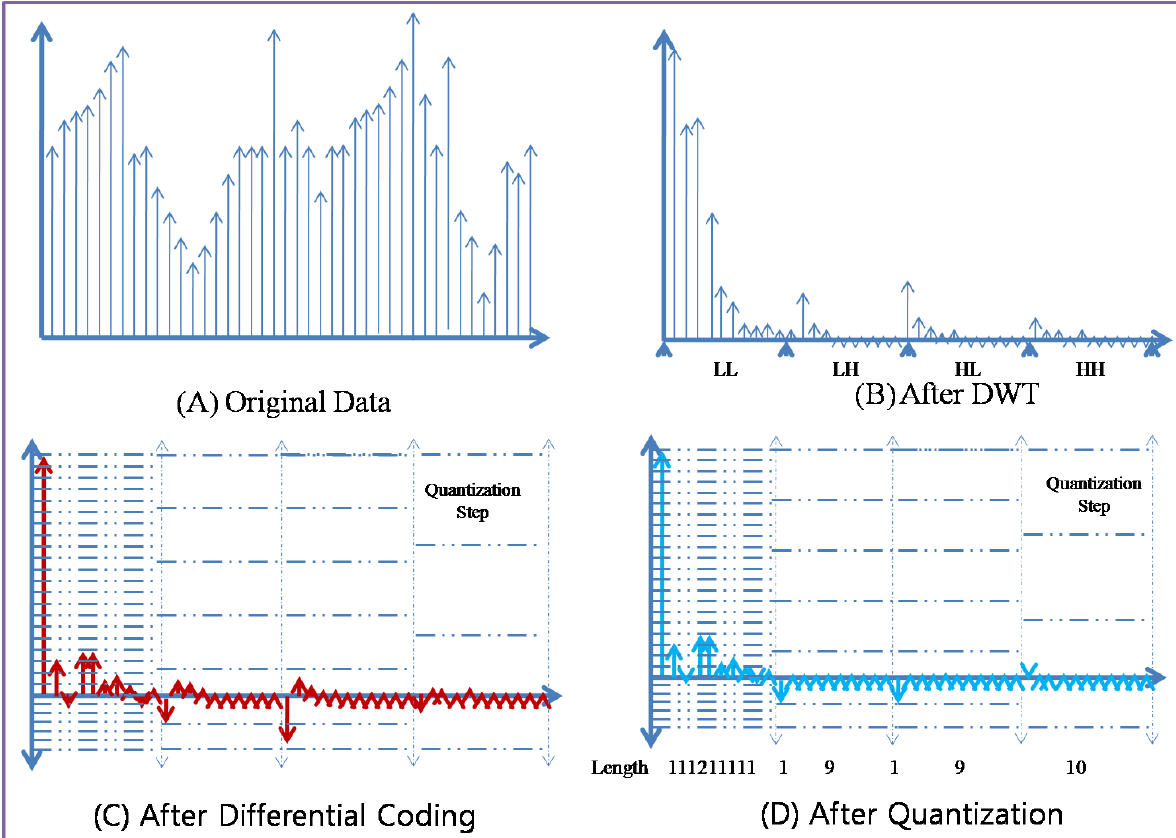
Figure 3. Example of Compression Techniques in